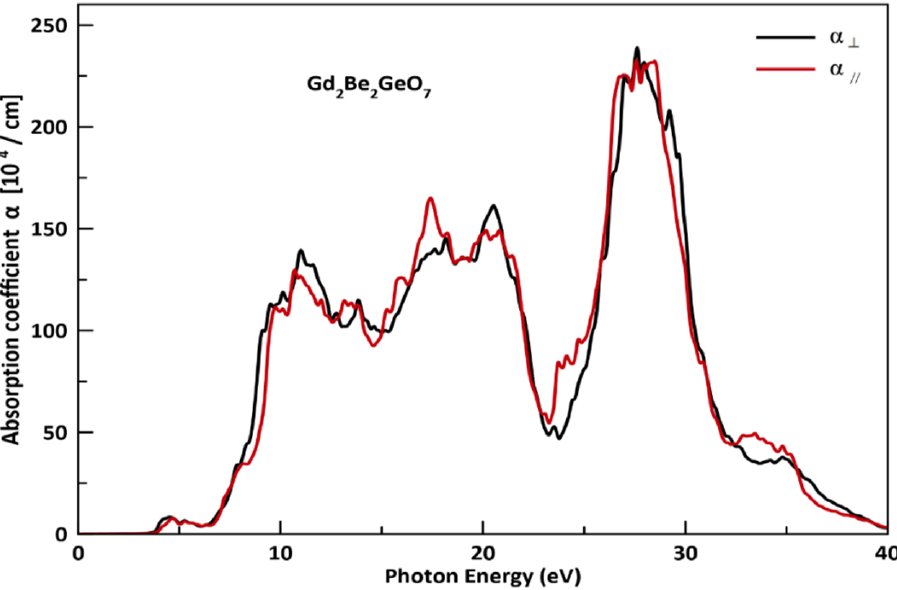
Figure 9. For the Gd 2 Be 2 GeO 7 compound, the absorption coefficient α ( ω ) was calculated in both parallel and perpendicular orientations .